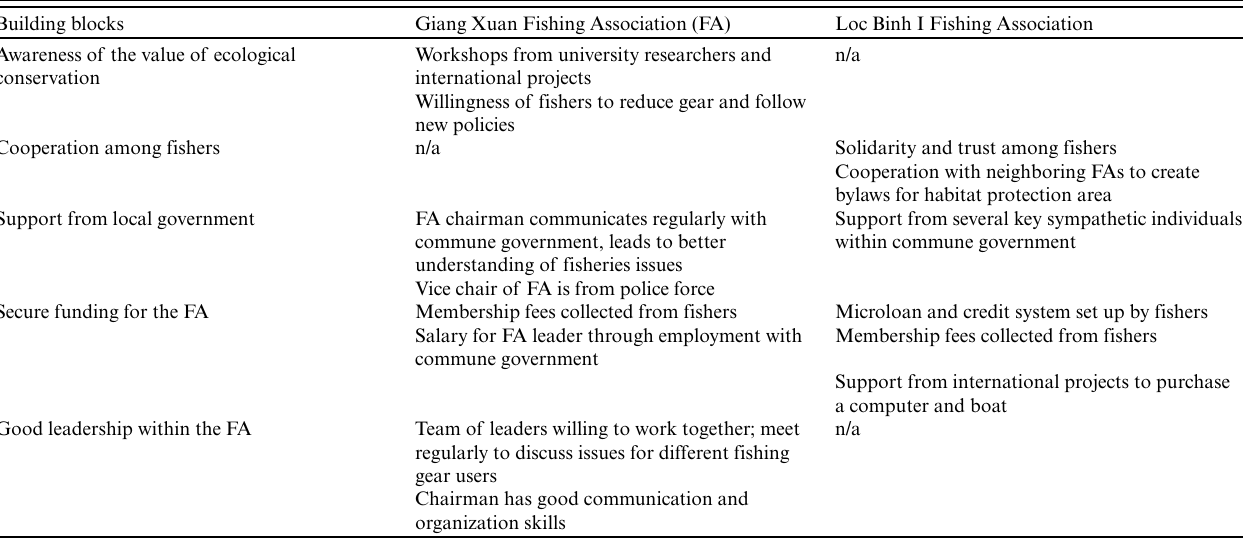
Table 2 . Cau Hai Lagoon building blocks and evidence for the building blocks in each